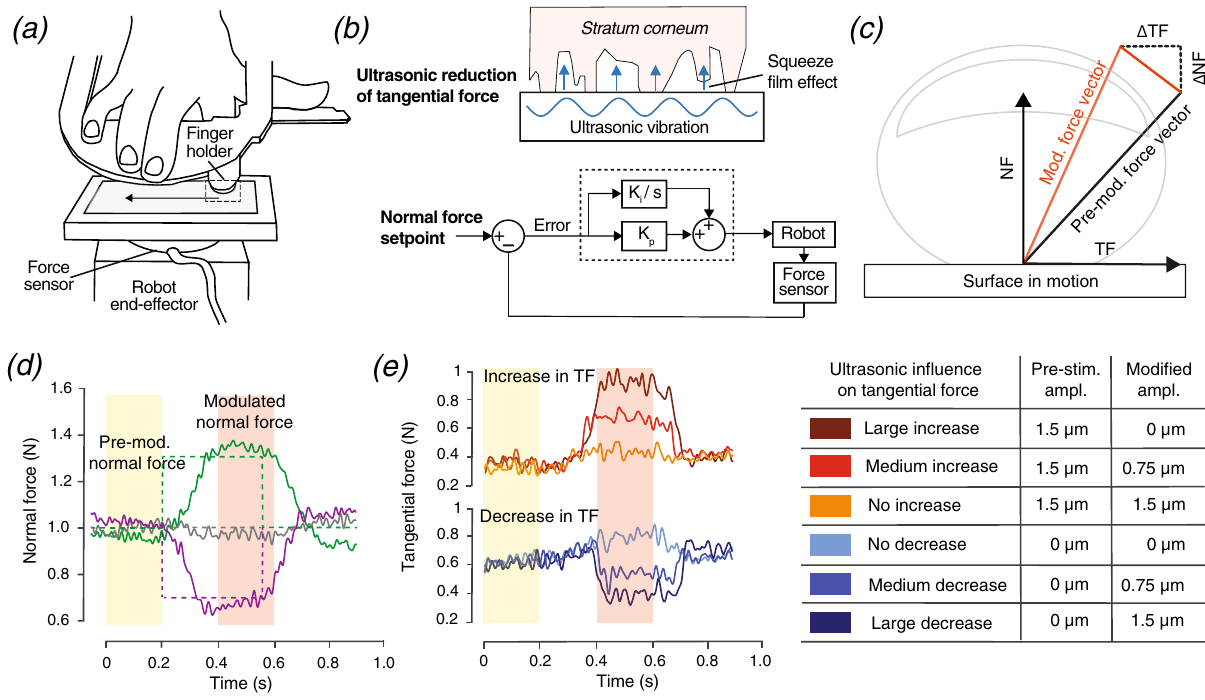
Figure 1. ( a ) The experimental apparatus used to independently modulate the normal force (NF) and tangential force (TF) that are applied on the index fingertip. ( b ) Upper: TF is modulated during sliding by vibrating the contact surface at an ultrasonic frequency (39 kHz) to create a microscale air film between the surface and the skin (squeeze film effect), hence reducing the finger-surface friction. Lower: diagram of the proportional-integral (PI) controller that enables the robotic platform to modulate NF according to a commanded pattern. ( c ) Illustration of the modulation of the contact-force vector when changes are induced compared to the pre-modulation NF and TF. TF is parallel to the contact surface, and NF is orthogonal to it. ( d ) Typical trials representative of the three normal force conditions: the briefly decreased normal force with ∆NF = − 0.3 N (purple), the constant normal force of 1.0 N (gray), and the briefly increased normal force with ∆NF = + 0.3 N (green). The setpoints are represented by the dashed lines. ( e ) Typical trials representing the six levels of change in TF. Three conditions start with no ultrasonic vibration, and the other three start with a constant 1.5 µm ultrasonic vibration. The changes in the intensity of the ultrasonic vibration and their impact on the finger-surface TF are displayed in the table on the right. One color is associated with each ultrasonic